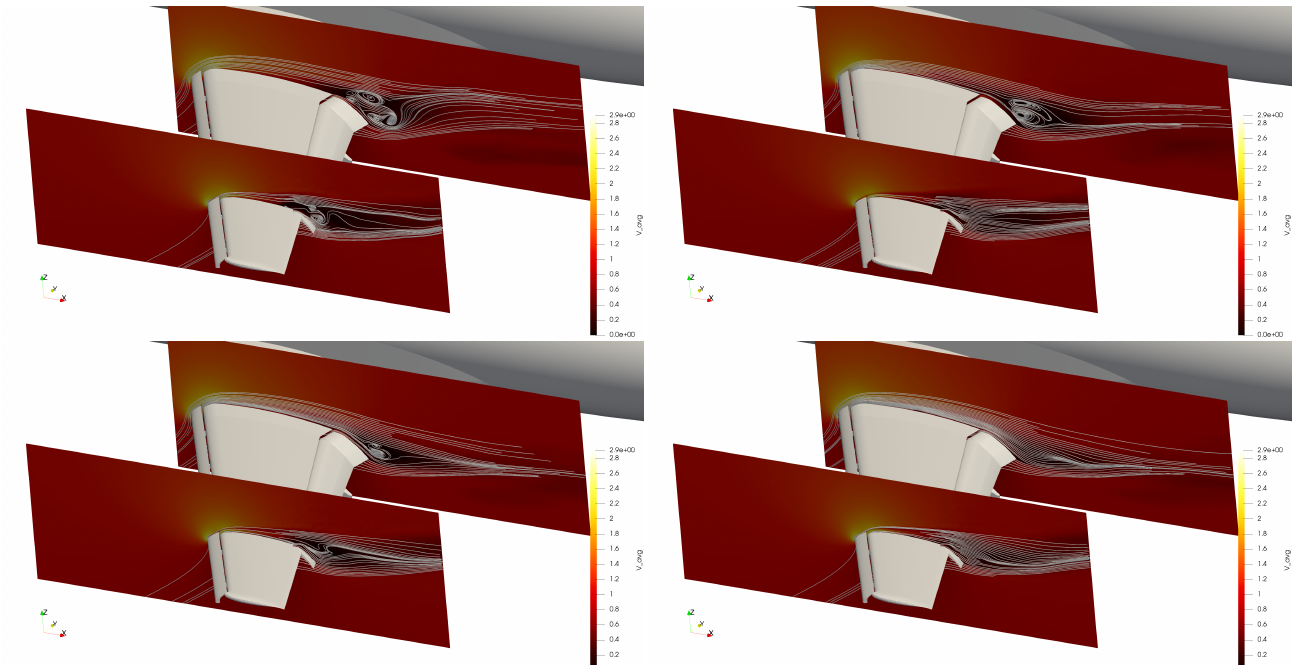
Figure 2. JAXA Standard Model high-lift configuration at Re c = 1.93 × 10 6 and AoA = 21.57 ◦ with AFC. Two-dimensional streamlines at different spanwise locations: baseline case vs. different actuator jet angles Φ . ( Top left ) baseline; ( top right ) Φ = 0 ◦ ; ( bottom left ) Φ = 60 ◦ ; and ( bottom right ) Φ = 45 ◦ . Results extracted from Ref. [62], with permission of the publisher (IOP